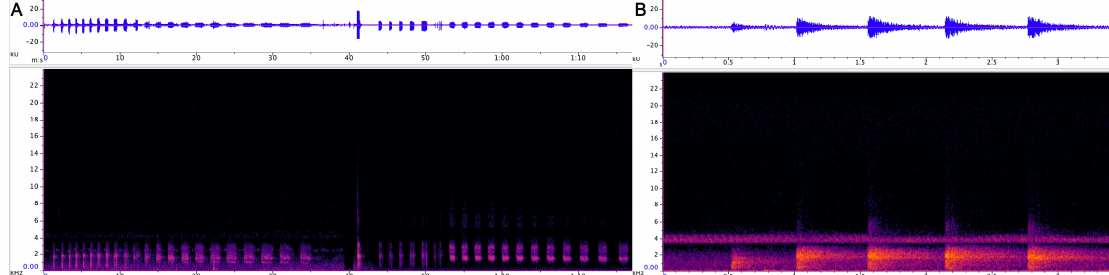
Figure 12. Dendrohyrax calls recorded from other parts of East Africa. ( A ) Dendrohyrax arboreus rattle screams recorded from Nairobi, Kenya, in 2000 by Andrew Perkin (Sound S24). ( B ) D. validus knocking sequence from recorded from Udzungwa Mountains, Tanzania, in 2001 by Thomas Butynski (Sound S25). Neither call is used by Dendrohyraxes in the Taita